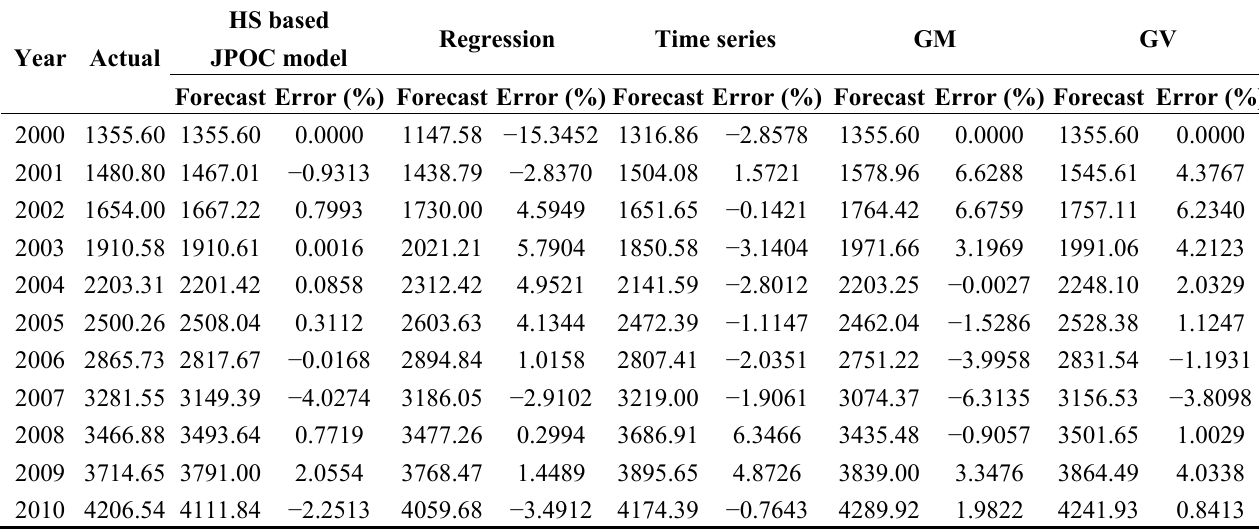
Table 3. Forecasting results of HS based JPOC model and other four single models for China (TWh).